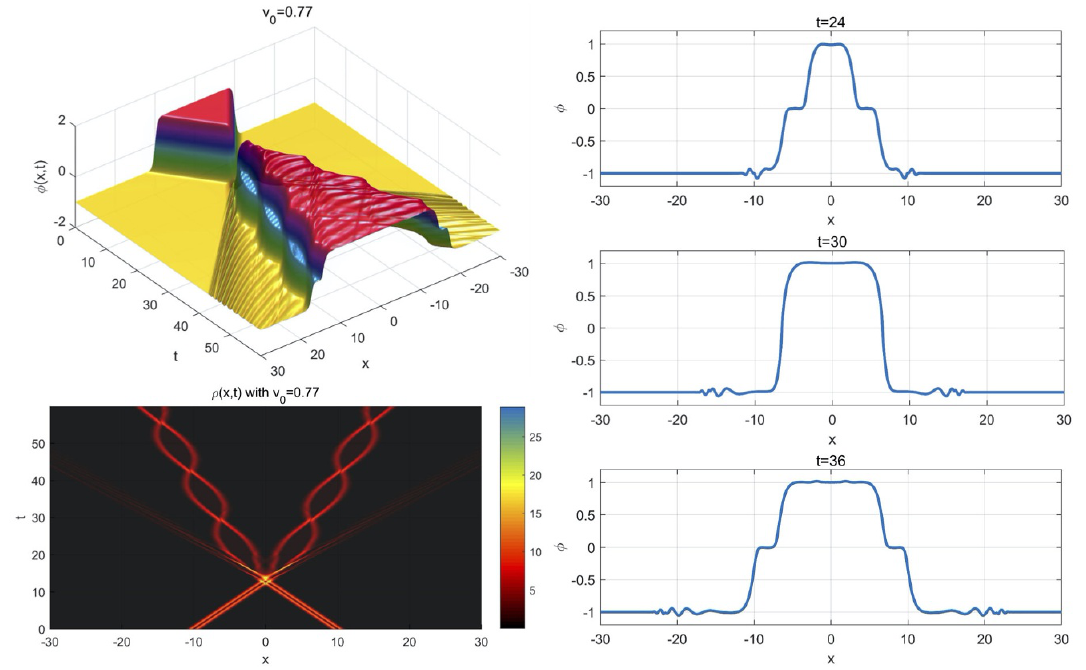
Figure 11 . The intertwined state found at n = 1 ; (cid:12) = 30 and v 0 = 0 : 77. The left column shows the evolution of the scalar (cid:12)eld con(cid:12)guration (upper panel) and the corresponding energy density (lower panel). The right column shows the scalar (cid:12)eld con(cid:12)gurations at t = 24 ; 30 ; 36, from which we can see that the intertwined state is a bound state of two kinks or two antikinks, which is essentially di(cid:11)erent to the bion. The simulations are conducted in spatial domain x = [ (cid:0) 50 ; 50] with (cid:12)rstly 1500 and then checked with 3000 collocation points. Here we only display the solutions in the range x = [ (cid:0) 30 ; 30]. The tolerance option of ode45 solver is set as RelTol=10 (cid:0) 3 and AbsTol=10 (cid:0) 6 . The relative error of energy is (cid:14)E rms (cid:24) 10 (cid:0) 3 for N = 1500, and (cid:14)E rms (cid:24) 10 (cid:0) 5 for N =